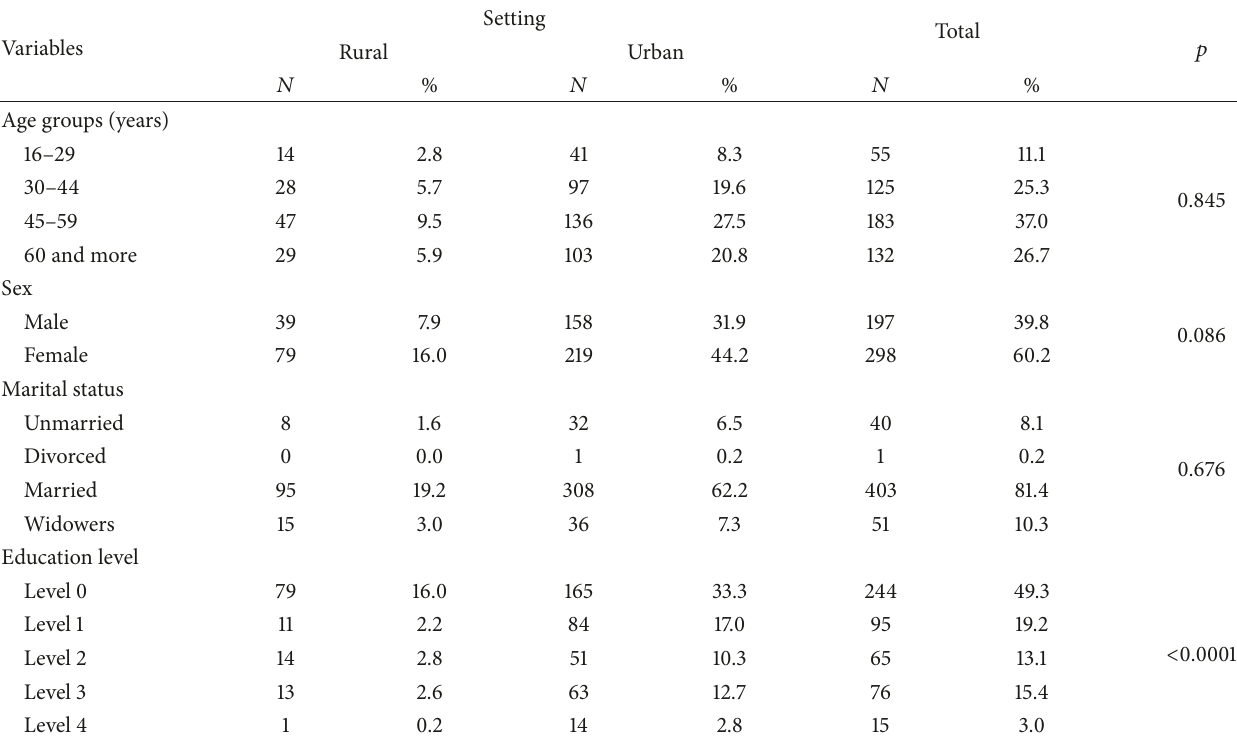
Table 2: Description of sociodemographic characteristics of 495 hypertensive subjects in the 2013 STEP survey in Mali.